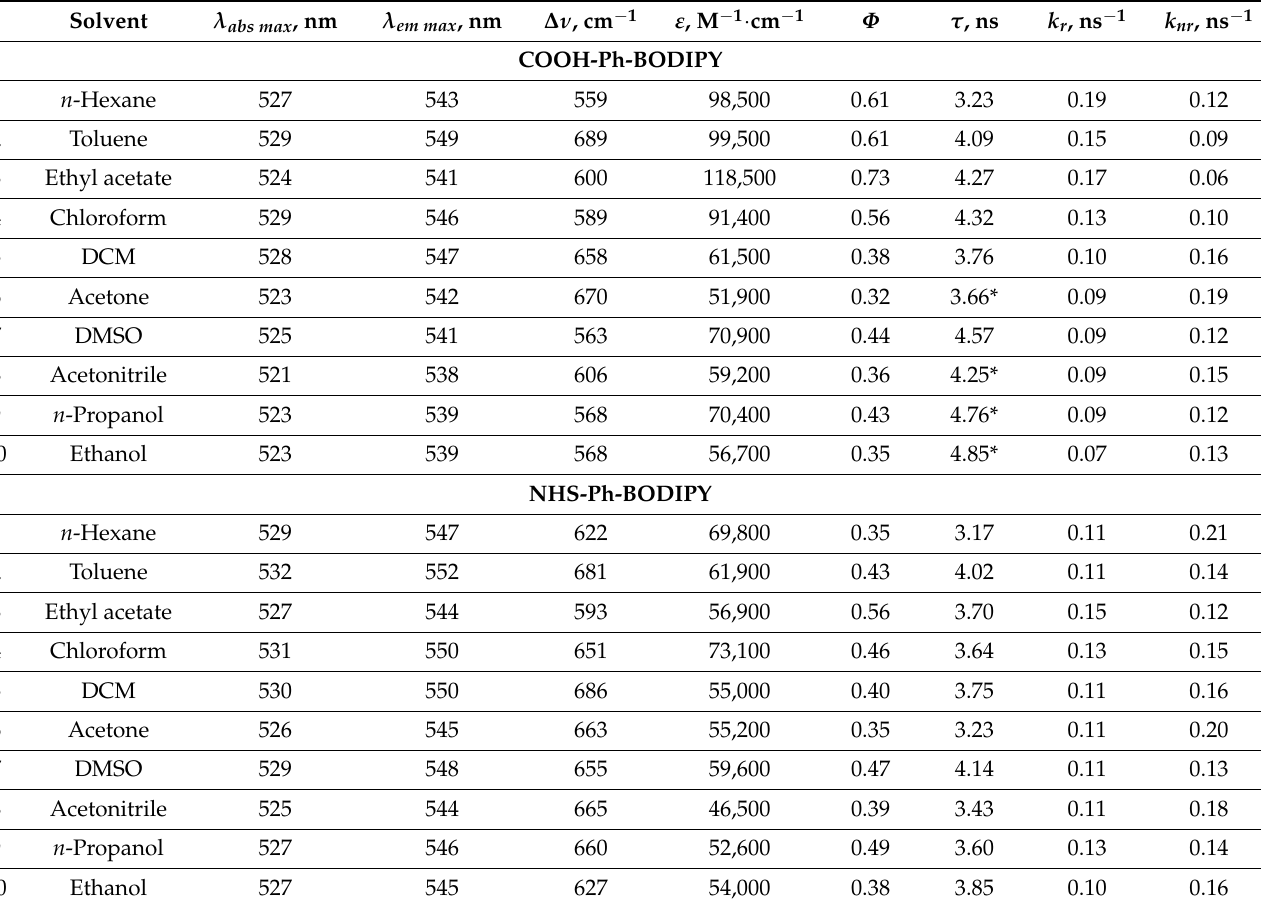
Table 1. Photophysical characteristics of COOH-Ph-BODIPY and NHS-Ph-BODIPY in organic solvents.